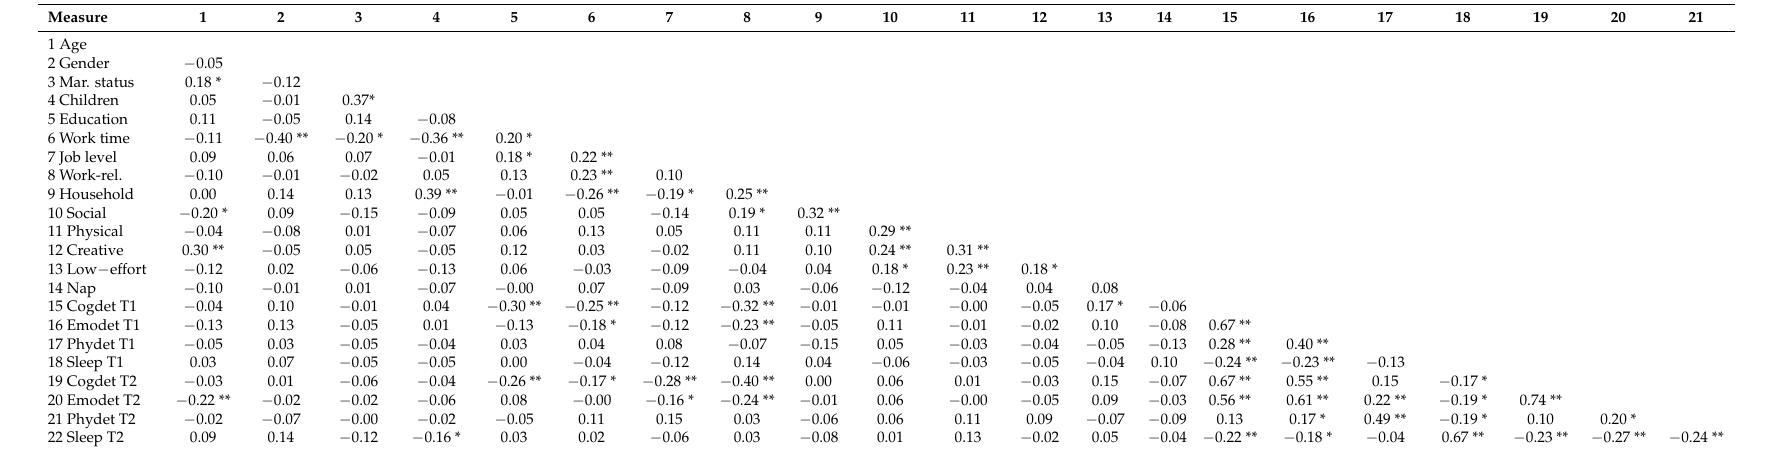
Table 1. Pearson zero-order correlation coefficients of the variables ( n =